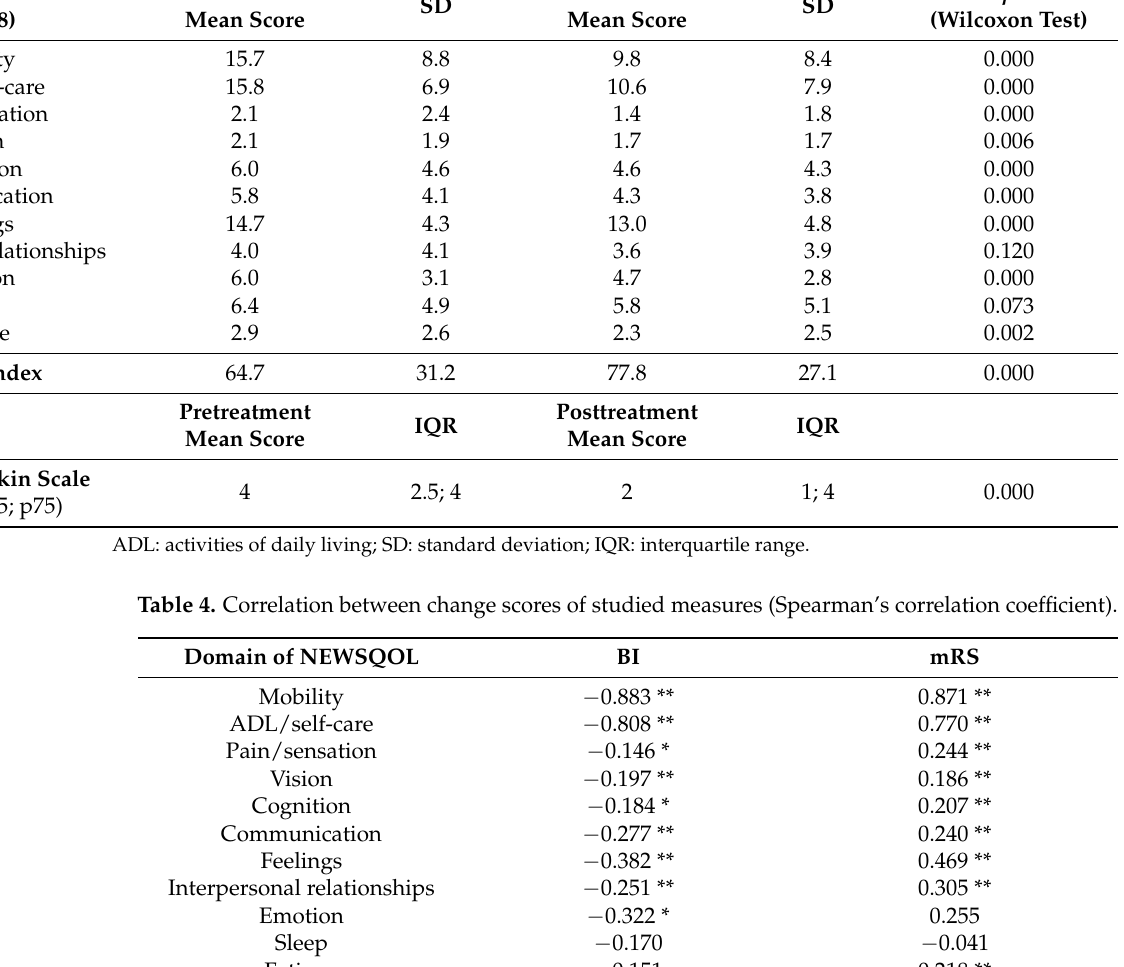
Table 3. Mean change in scores of the Spanish version of the NEWSQOL questionnaire, BI and mRS. NEWSQOL